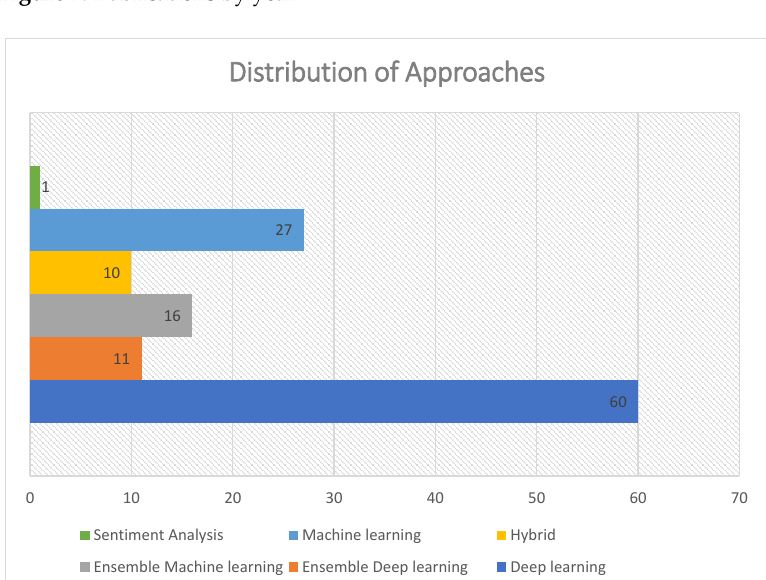
Figure 7. Publications by year.